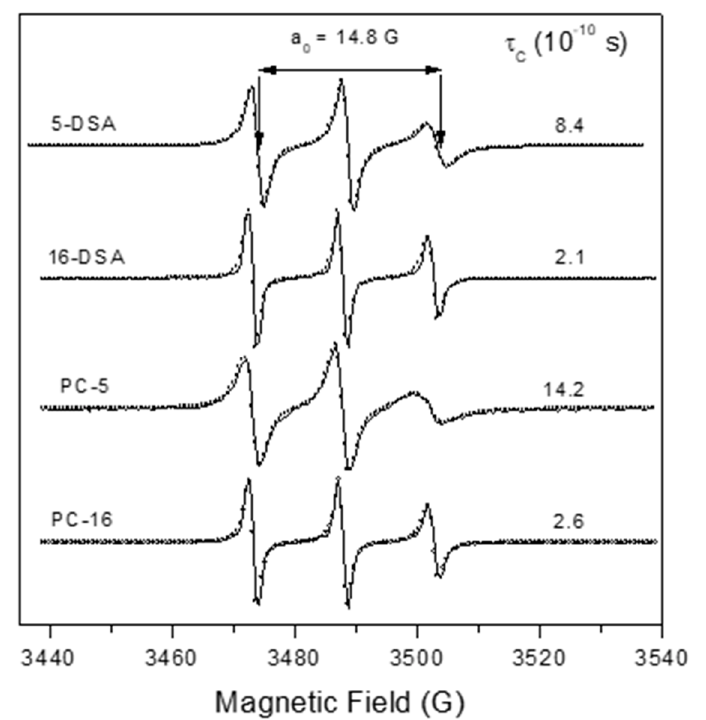
Figure 2. Experimental (solid line) and best-fit (empty circles) EPR spectra for several spin labels in BAMPA. The isotropic 14N-hyperfine coupling constant, a 0 , showed equal spectra values of 14.8 G, consistent with a spin label in phospholipidic bilayer of eukaryotic cells. The rotational correlation time value, τ C, is also showed. 5-DSA or 16-DSA: 5- or 16-doxylstearic acid); 5-PC or 16-PC:5-0r 16- phosphatidylcholine).